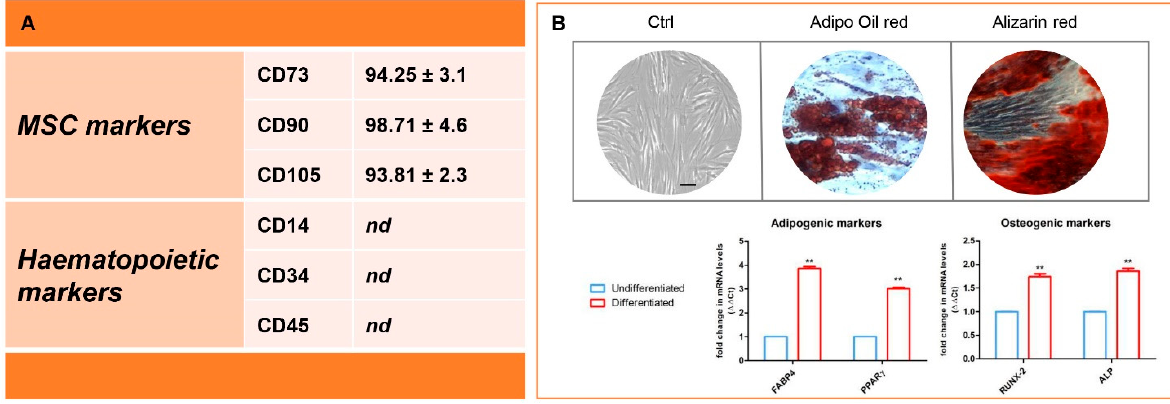
Figure 1. Human Gingival Mesenchymal Stem Cells (hGMSCs) characterization. ( A ) Antigen expression quantification by flow cytometry in human Gingival Mesenchymal Stem Cells (hGMSCs). Cells do not express hematopoietic antigens CD14, CD34 and CD45 and co-express CD73, CD90 and CD105. ( B ) Differentiation assay: cultured hGMSCs were induced to differentiate into adipocytes and osteoblast. Adipogenic differentiation was demonstrated by lipid vacuole detection with the lipid adipo oil red staining; and calcium deposits in the osteoblast differentiation were detected with alizarin red staining. Graph bars showed the expression of specific markers in cells undergoing adipogenic and osteogenic differentiation. Results represent three independent experiments performed in triplicate ( n = 3). MSC: mesenchymal stem cell; nd: not detectable; FABP4: fatty acid-binding protein 4; PPAR γ : peroxisome proliferator-activated receptor γ ; RUNX-2: Runt-related transcription factor-2; ALP: alkaline phosphatase. Scale bar: 20 μ m. ** p < 0.01.